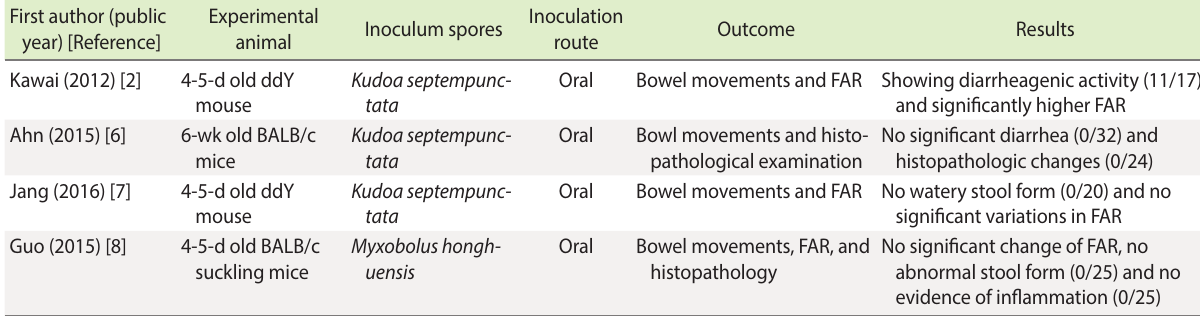
Table 2. Summary of the evidence related to the pathogenicity of Myxosporean